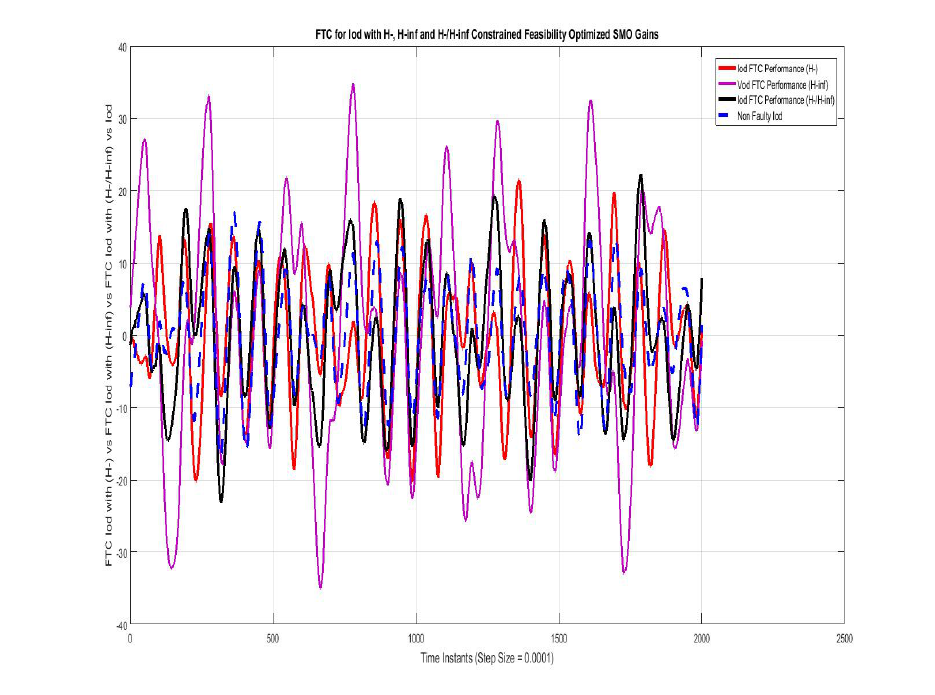
Figure 14. FTC for Voq compared with feasibility optimized H − and H − / H ∞ SMO